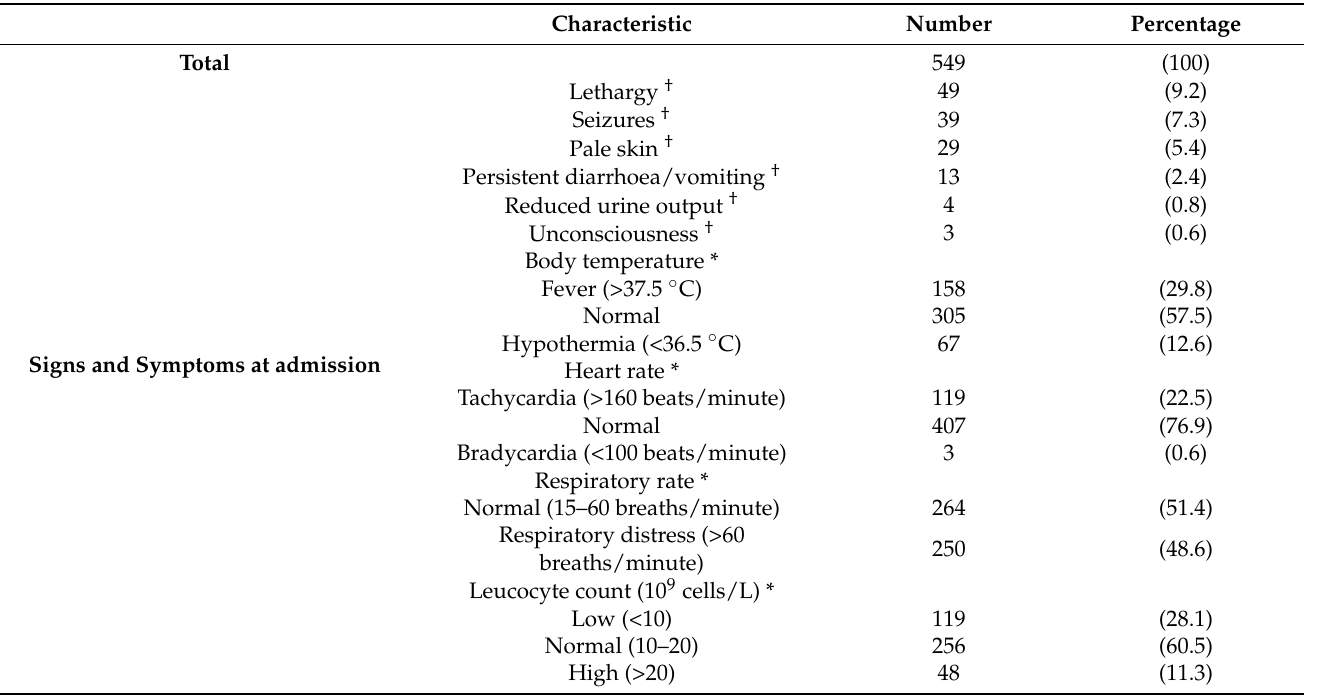
Table 2. Clinical characteristics of neonates admitted with suspected sepsis at Komfo Anokye Teaching Hospital, Ghana, between January 2021 and December 2021.